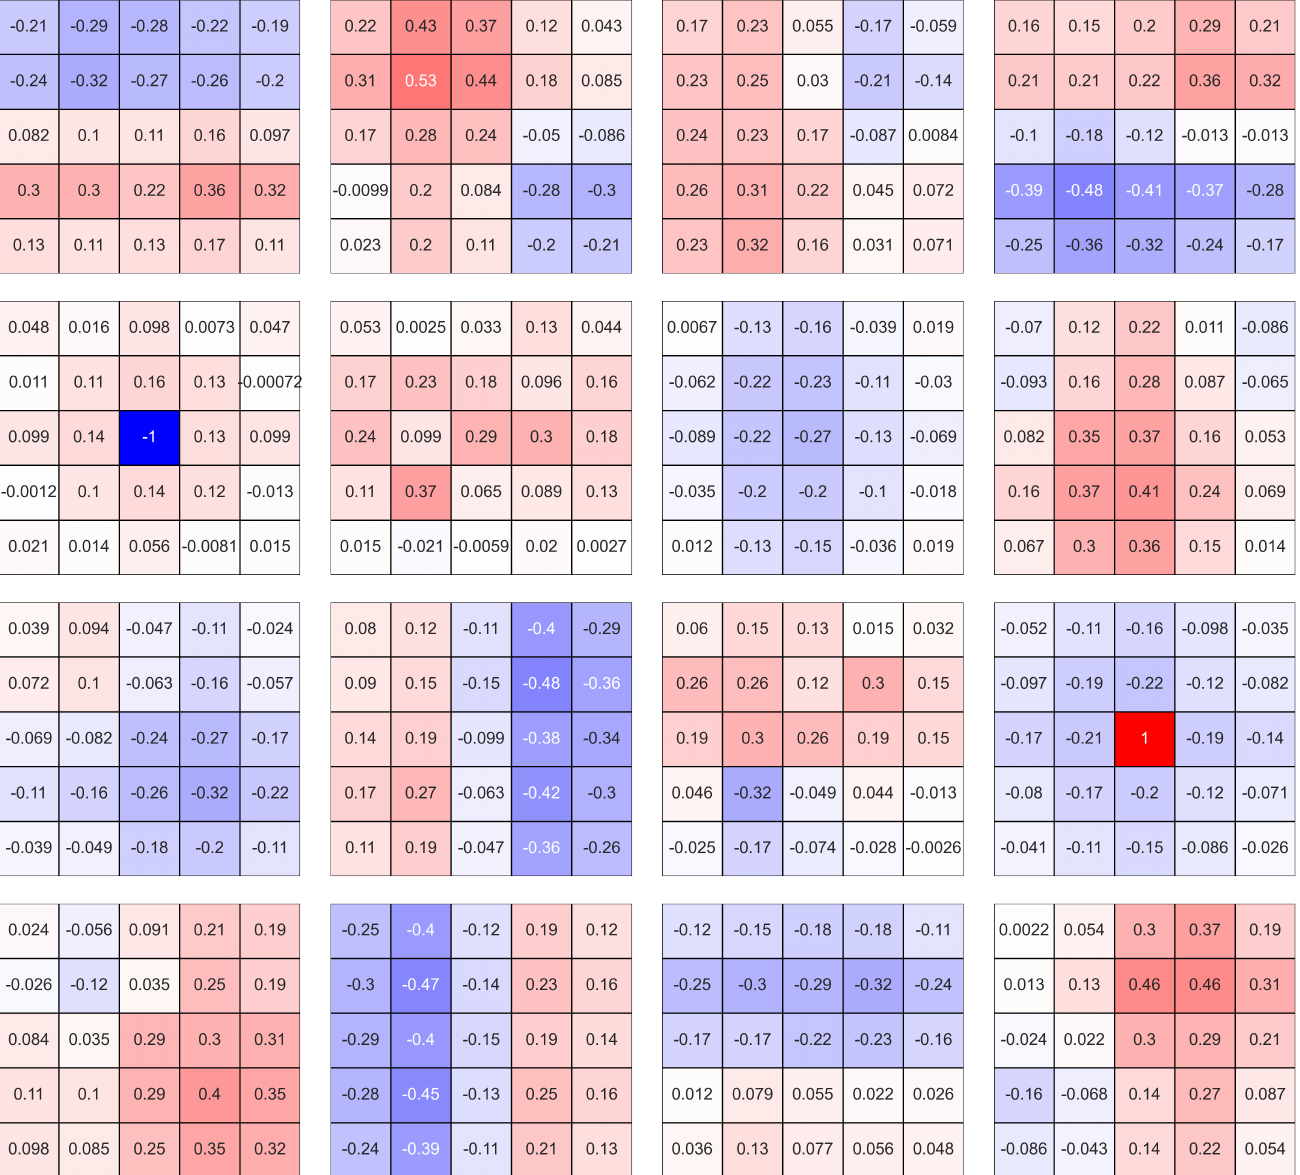
Figure A1. Normalized kernels of 1st layer of Fully CNN with filtered